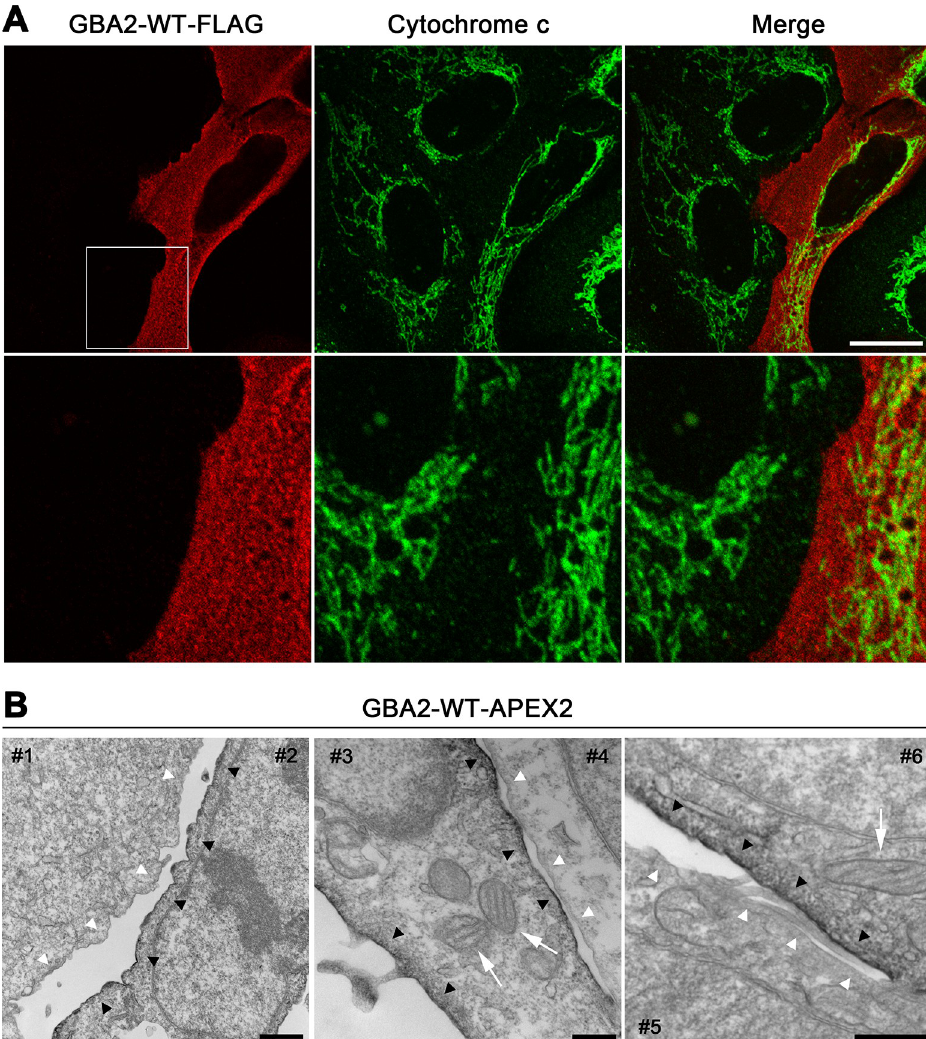
Fig 2. GBA2-WT is localized at the plasma membrane. (A) U2OS cells were transfected with a cDNA coding for GBA2-WT-FLAG under the control of the CMV promoter, immunostained with anti-FLAG (red) and anti- cytochrome c antibodies (green), and imaged via confocal microscopy. A section (white square) of the images in the upper panels is enlarged in the lower panels. Scale bar, 20 μ m. (B) U2OS cells were transfected with a cDNA coding for GBA2-WT-APEX2 under the control of the CMV promoter, stained with DAB, and processed for electron microscopy. Each panel shows one transfected cell (#2, 3, and 6) and one non-transfected cell (#1, 4, and 5). Black arrowheads point to APEX2-stained plasma membranes; white arrowheads point to non-APEX2-stained plasma membranes. APEX2-stained plasma membranes were more electron-dense compared to non-APEX2-stained plasma membranes. White arrows point to mitochondria. Representative images are shown. Scale bars: left panel, 1000 nm; middle panel, 400 nm; right panel, 500 nm.